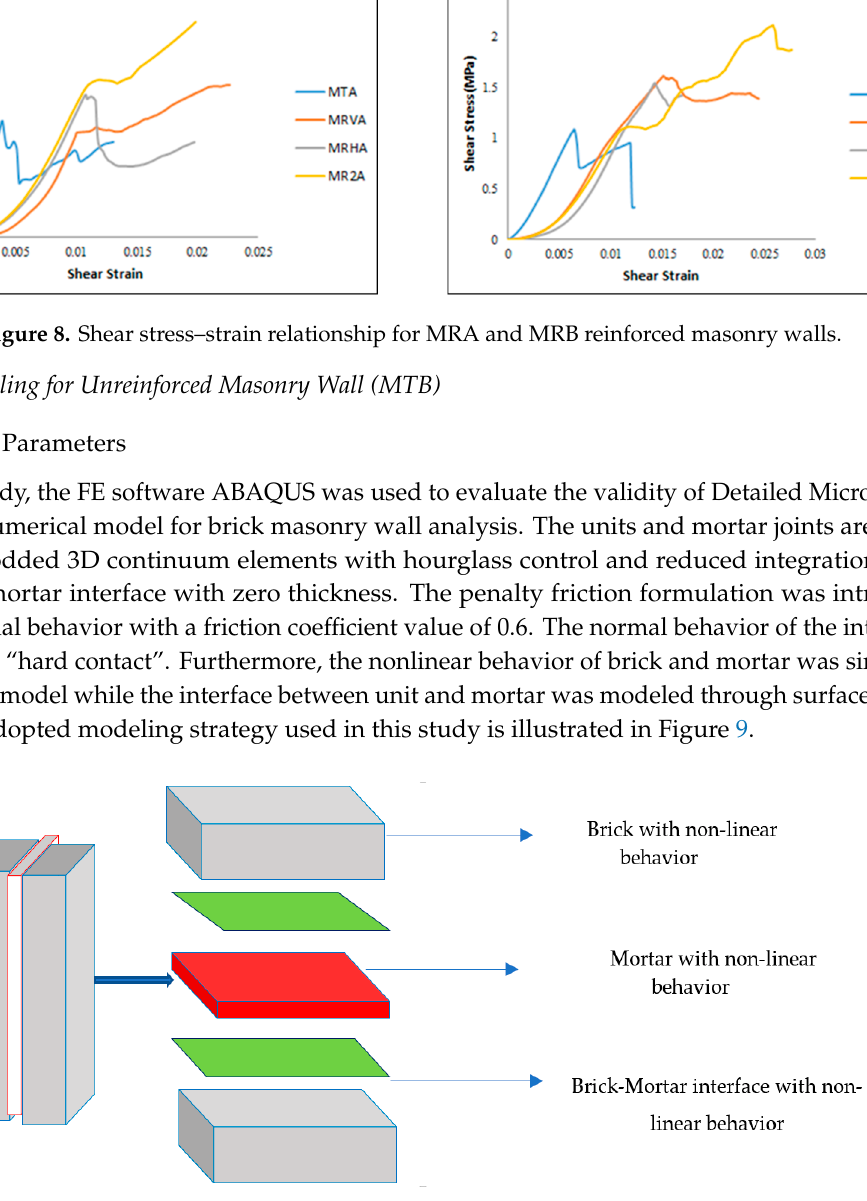
Figure 7. Failure modes of all reinforced masonry walls.